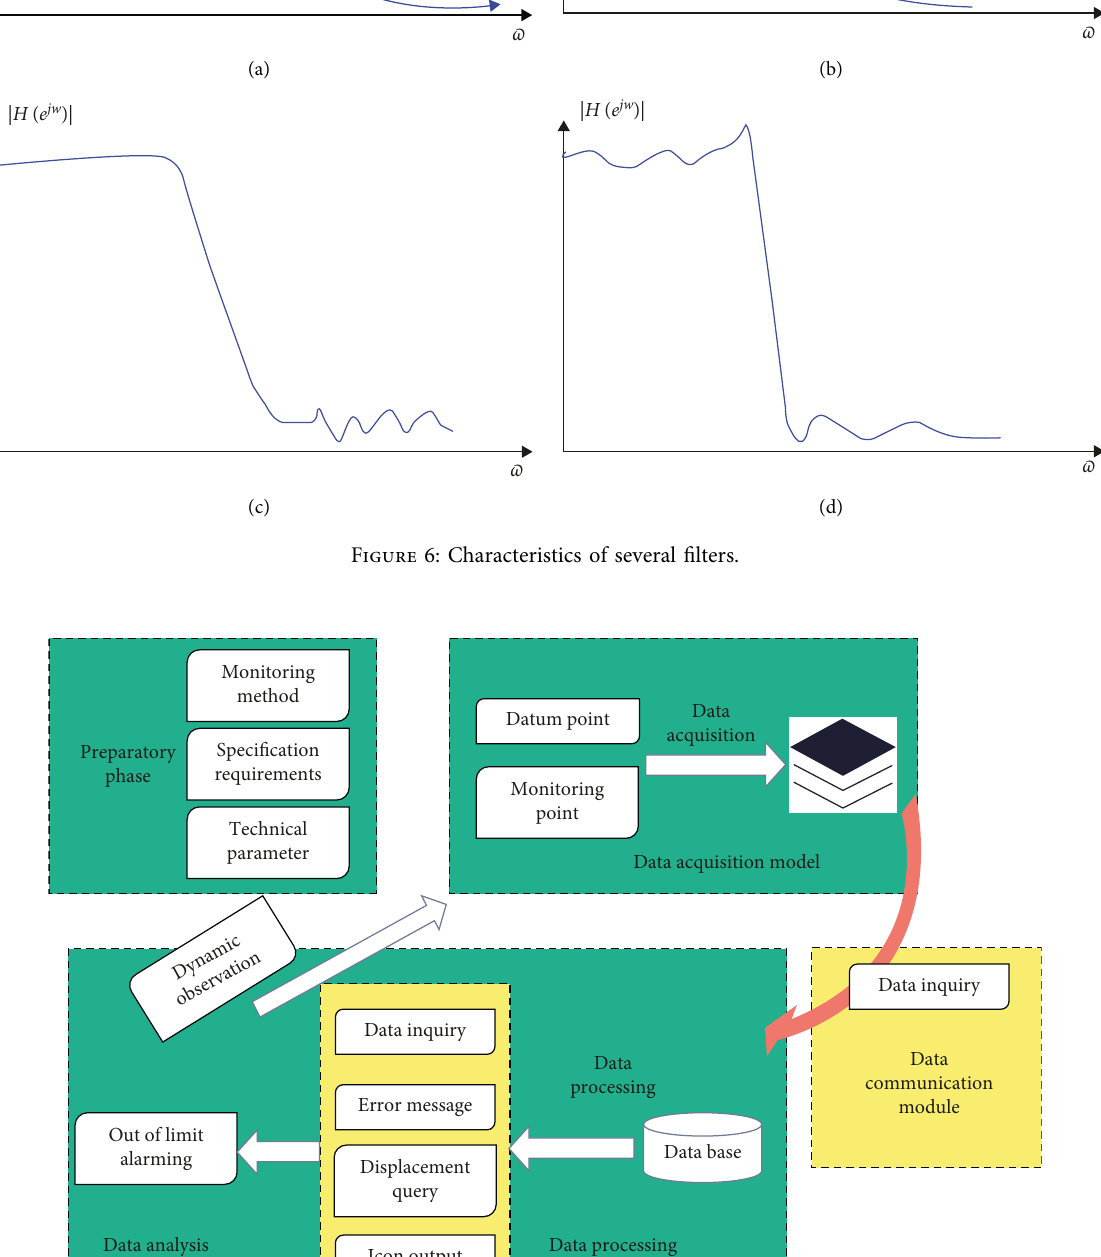
Figure 7: Structure diagram of robot monitoring system.